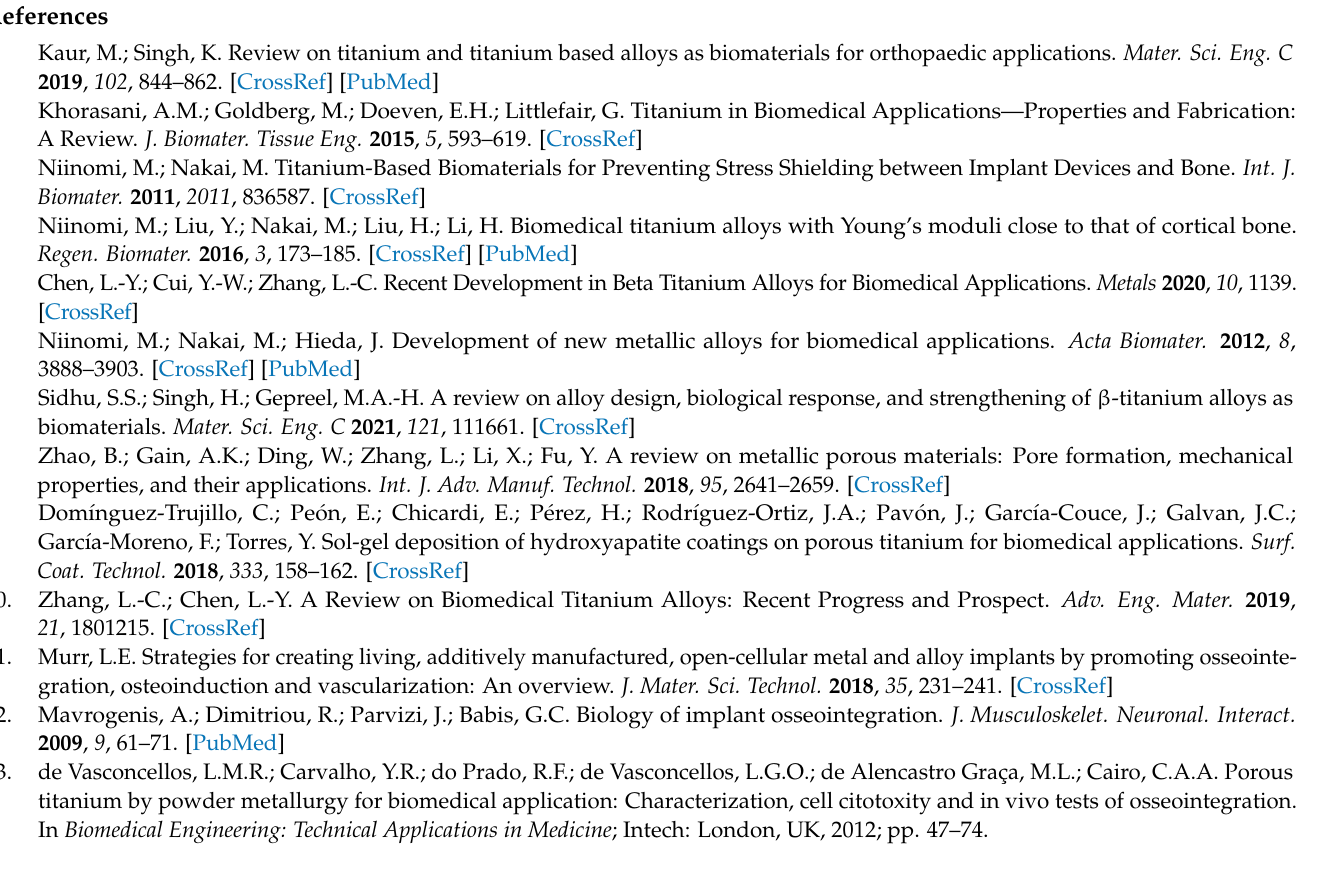
Figure S2: Resistance to penetration evaluated by scratch tests, for the pore range size 100–200 µ m and two porosities; Figure S3: Scanning electron microscopy image of the scar on a substrate of 60% vol% and pore range size 355–500 µ